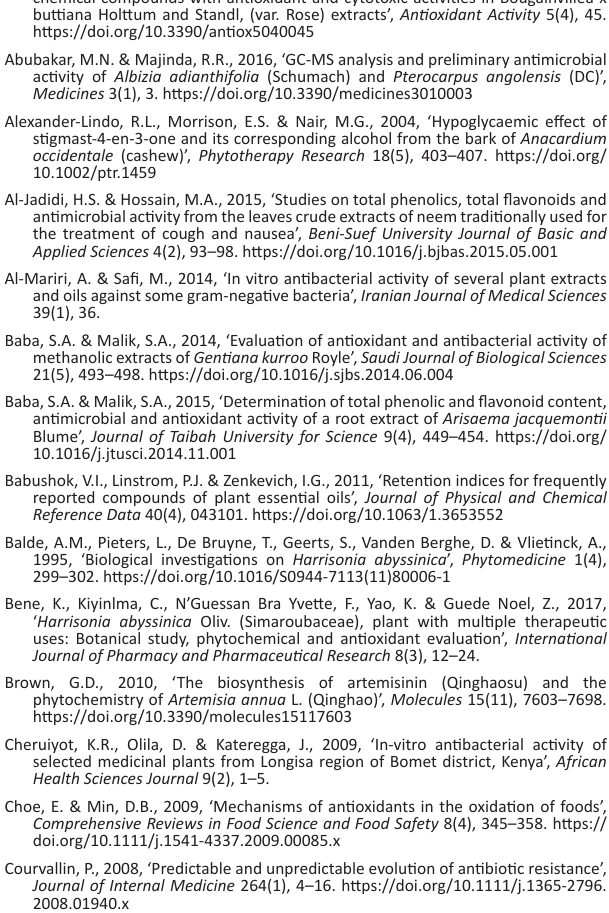
TABLE 8: Pearson’s correlation coefficient values for EC flavonoids.